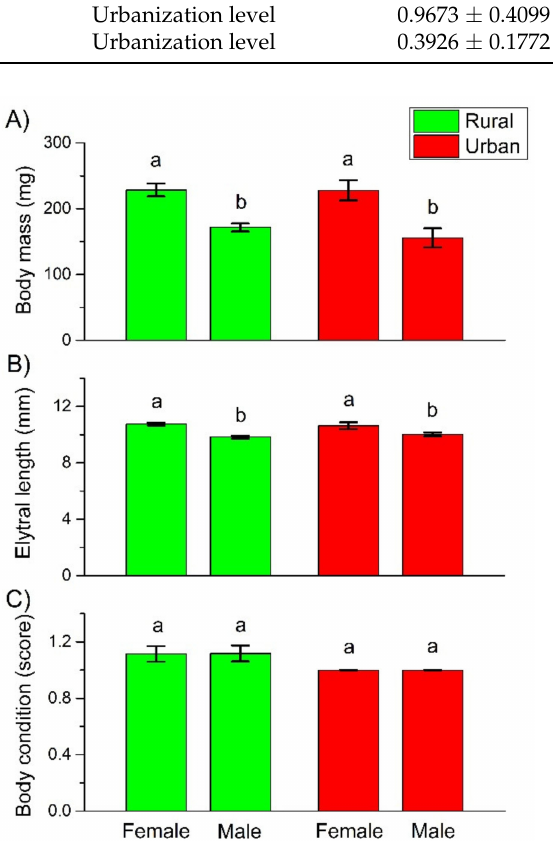
Figure 1. Mean ( ± SE) body mass ( A ), elytral length ( B ), and body condition, characterized by the amount of fat content using a three-level scale, where 1 denotes few, 2 moderate, and 3 large amount of fat content ( C ), of C. convexus individuals sampled in rural and urban habitats. Different letters indicate significant differences based on the LSD test ( p <